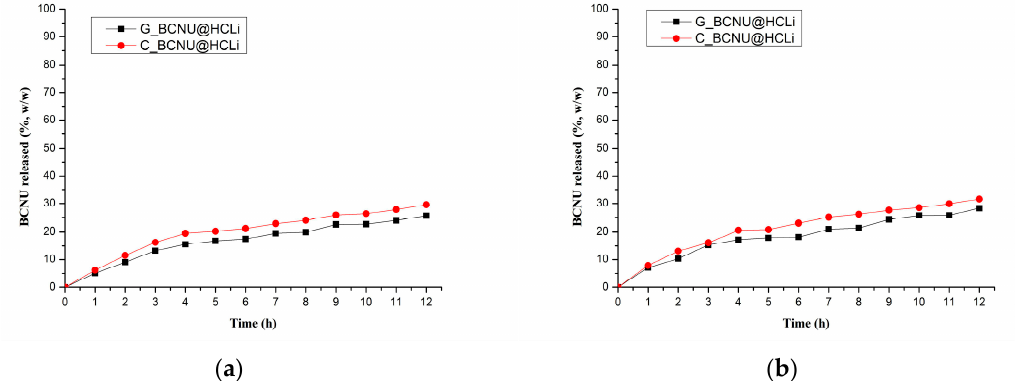
Figure 4. In vitro cumulative release of BCNU from BCNU@HCLI formulated as two types of semisolid dosage forms: ( a ) Nylon membrane; ( b ) Collagen membrane.